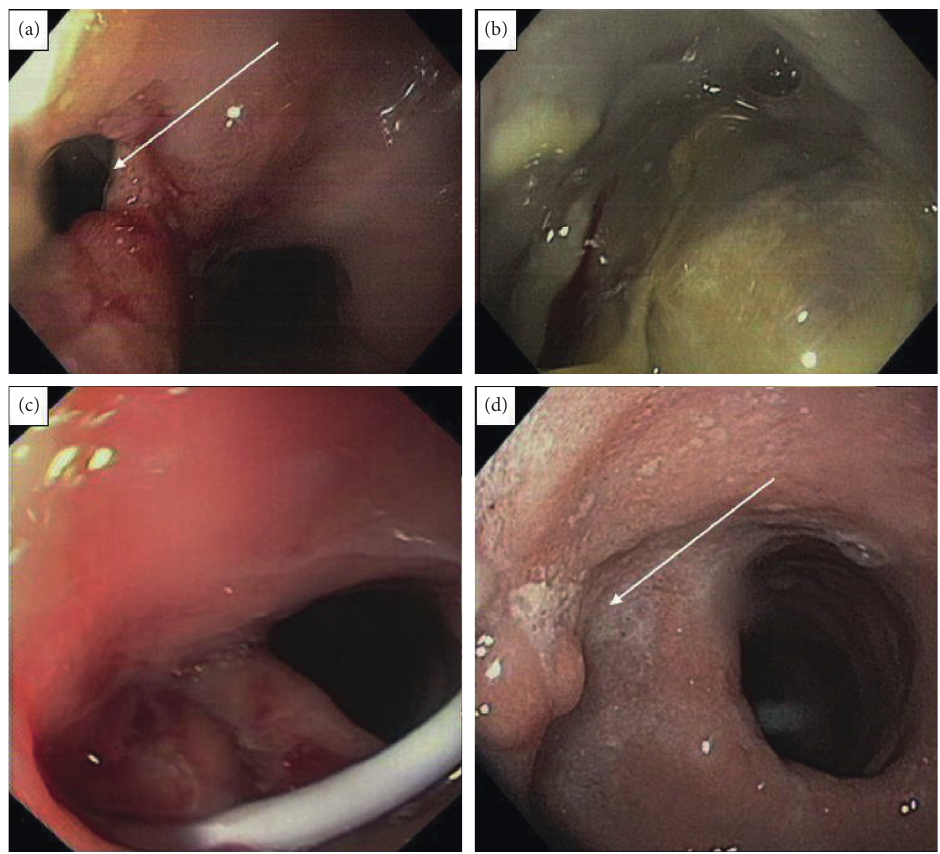
Figure 3: Endoscopic views of an early complicated patient. The GL documented with GSTand CTscans now appears evident at endoscopic inspection ((a)) (with arrow). A large walled-off perifistular collection suspected at GST (Figure 1(b)) is confirmed at the endoscopic inspection (b). (c) EDPC positioned. (d) Endoscopic control at the 28 th POD: internal drainage acts like a foreign body and promotes the physiological re-epithelization of the leak (white